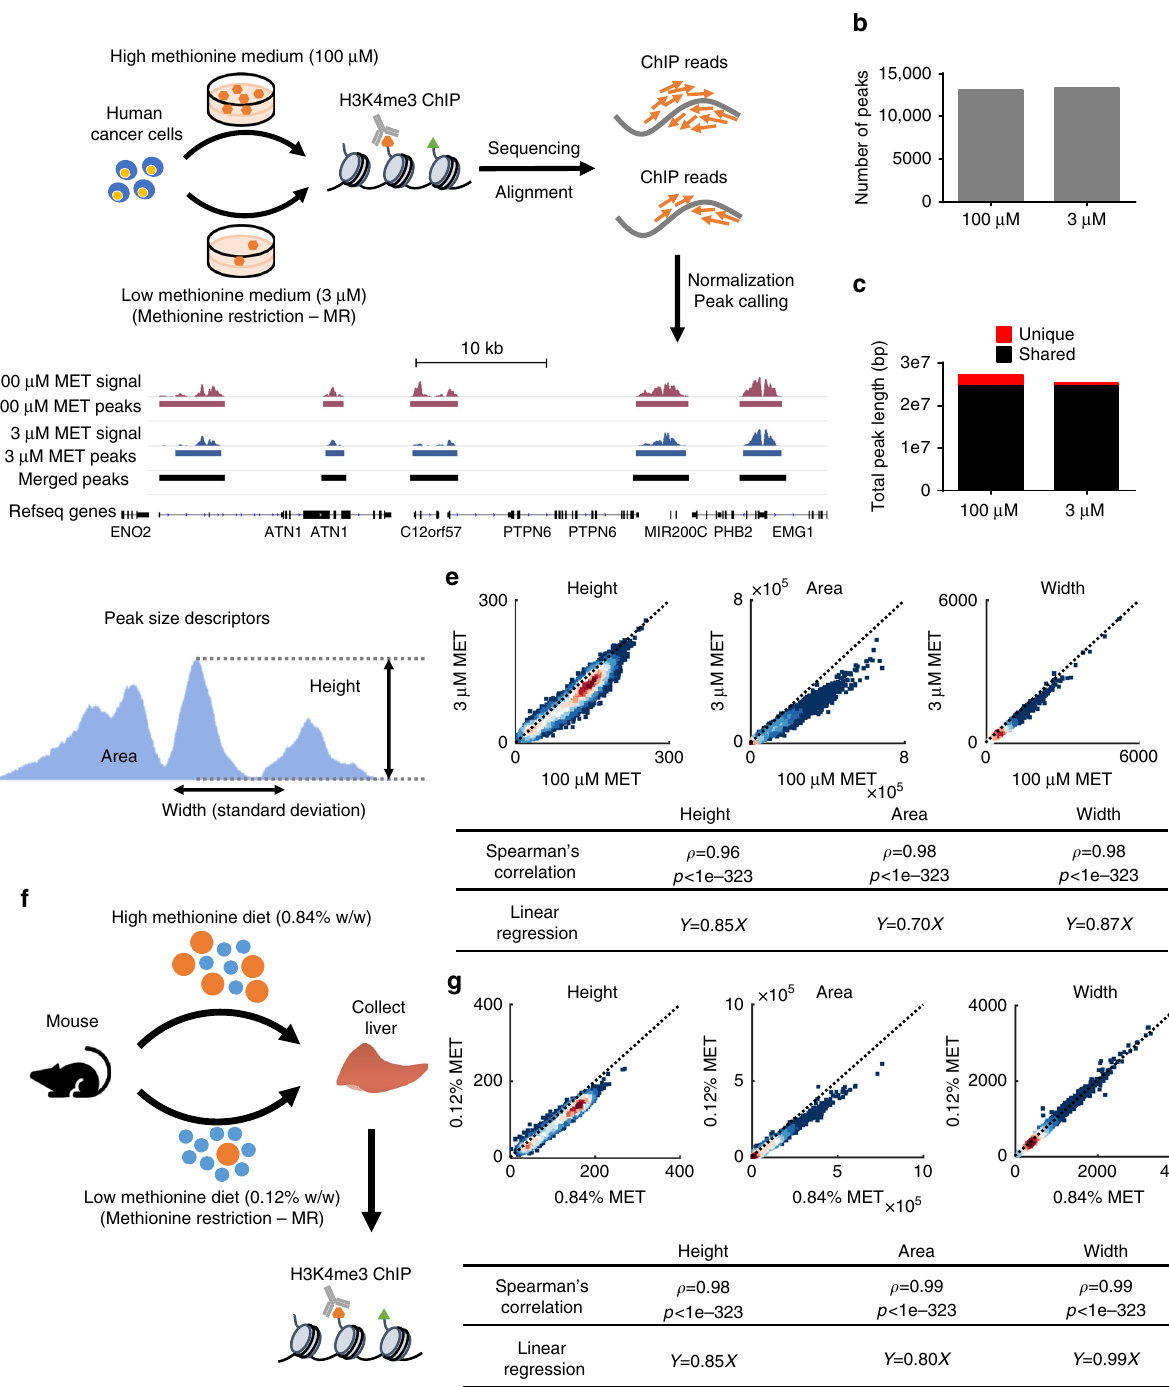
Fig. 1 MR reduces H3K4me3 but maintains its genomic distribution. a MR experiment and ChIP-seq data analysis pipeline in human cancer cells HCT116. b Number of H3K4me3 peaks called under high (100 μ M) and low (3 μ M) methionine conditions in human cancer cells. c Total length of shared and unique peak regions for high and low methionine conditions in human cancer cells. d De fi nition of peak height, area, and width. e Density scatter plots comparing H3K4me3 peak heights, areas, and widths between high and low methionine conditions in human cancer cells. Colors represent for dot density. Dashed lines show identical x and y coordinates. Spearman ’ s rank correlation coef fi cients between the high and low methionine conditions and linear regression coef fi cients are shown in the table at bottom. f MR experiments scheme in vivo. Mouse image used with permission from Microsoft. g Density scatter plots comparing H3K4me3 peak heights, areas, and widths in mouse liver between high (0.84% w/w) and low (0.12% w/w) methionine